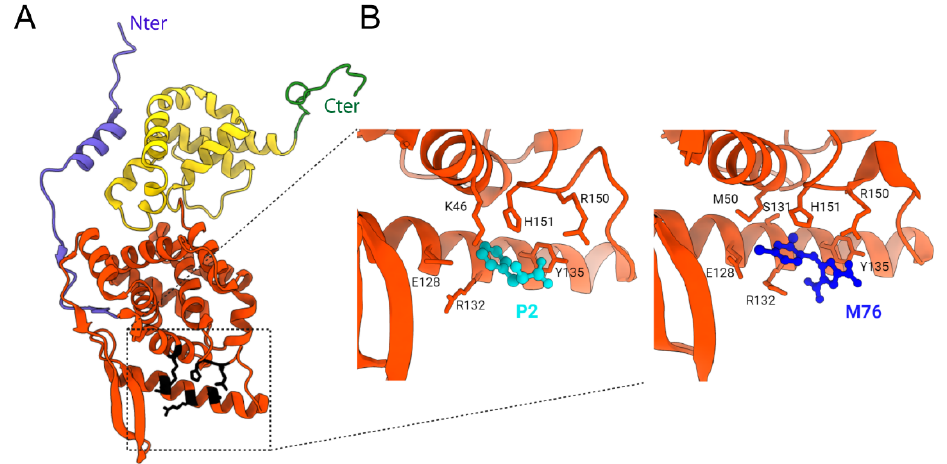
Figure 6. X-ray structure of hRSV N protein protomer and of N NTD in complex with P2 peptide and M76 compound. ( A ) An hRSV N protomer taken from the X-ray structure of N-RNA rings (PDB 2WJ8) is represented in ribbons, with the N NTD in orange, N CTD in yellow, and the N- and C-terminal arms in blue and green, respectively. The residues of N critical for the interaction with P are shown with lateral chains in black. N- and C-terminal extremities are indicated. ( B ) Zoom into the P2-binding site on N NTD (left panel, P2 in cyan) (PDB: 4UCA) and of the M76 compound binding site (right panel, M76 in deep blue) (PDB: 4UCC). The residues of N involved in the interaction with P2 or M76 are indicated. Created with UCSF Chimera [104].